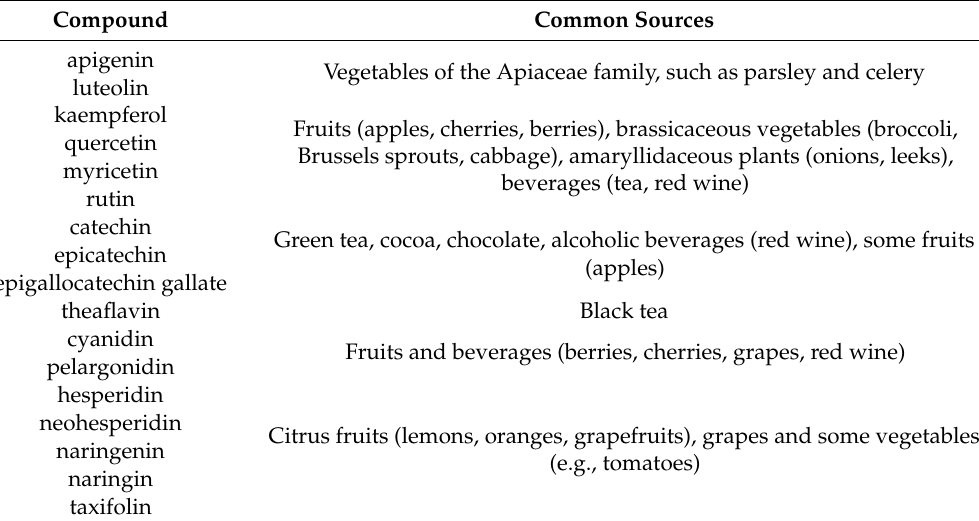
Table 1. Common sources of dietary